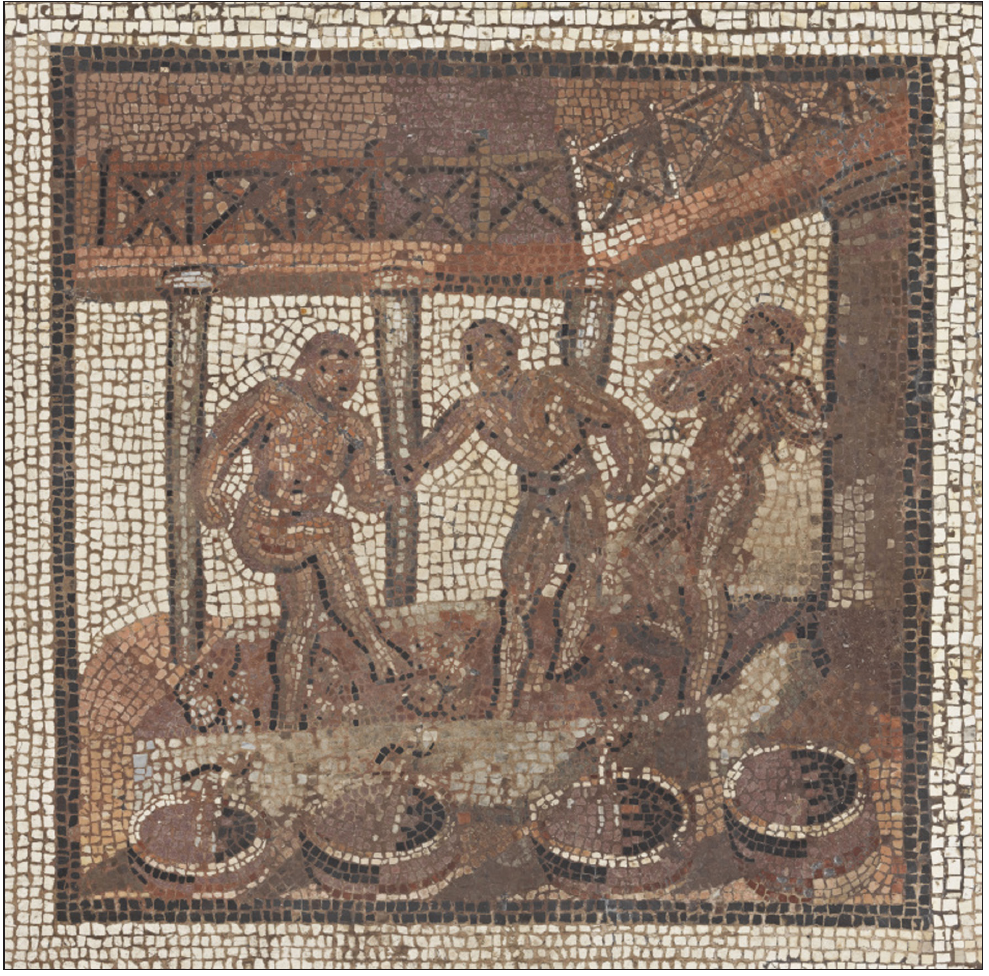
Figure 2: Portion of Le Calendrier Rustique , St. Romain-en-Gal, showing wine-pressing. (Photo: RMN-Grand Palais (Musée d’Archéologie Nationale)/Michel Urtado – Automatic permission for non-commercial re-use with correct